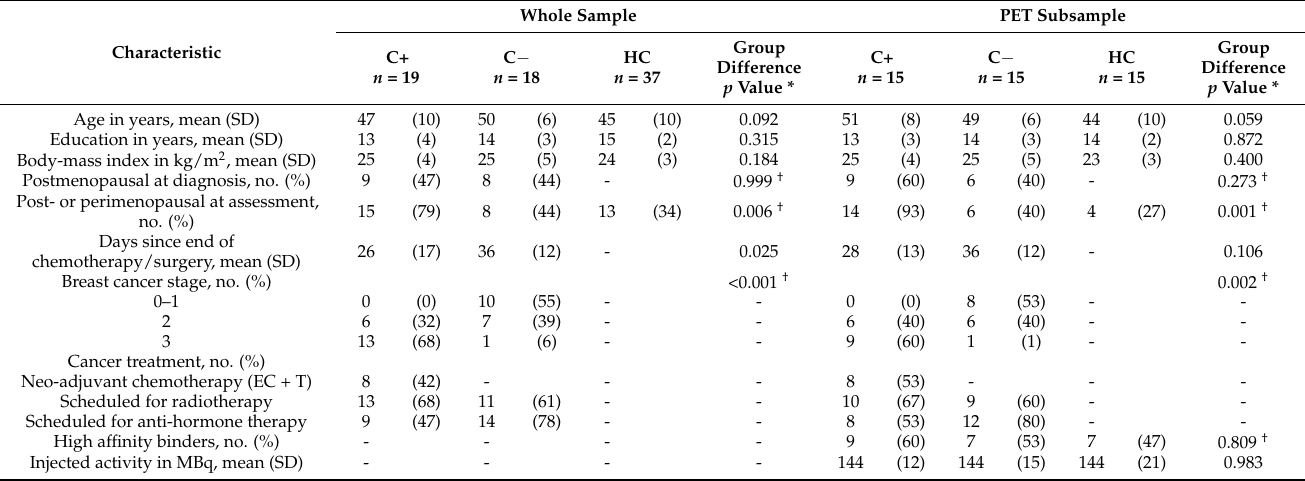
Table 1. Demographics and characteristics of the study